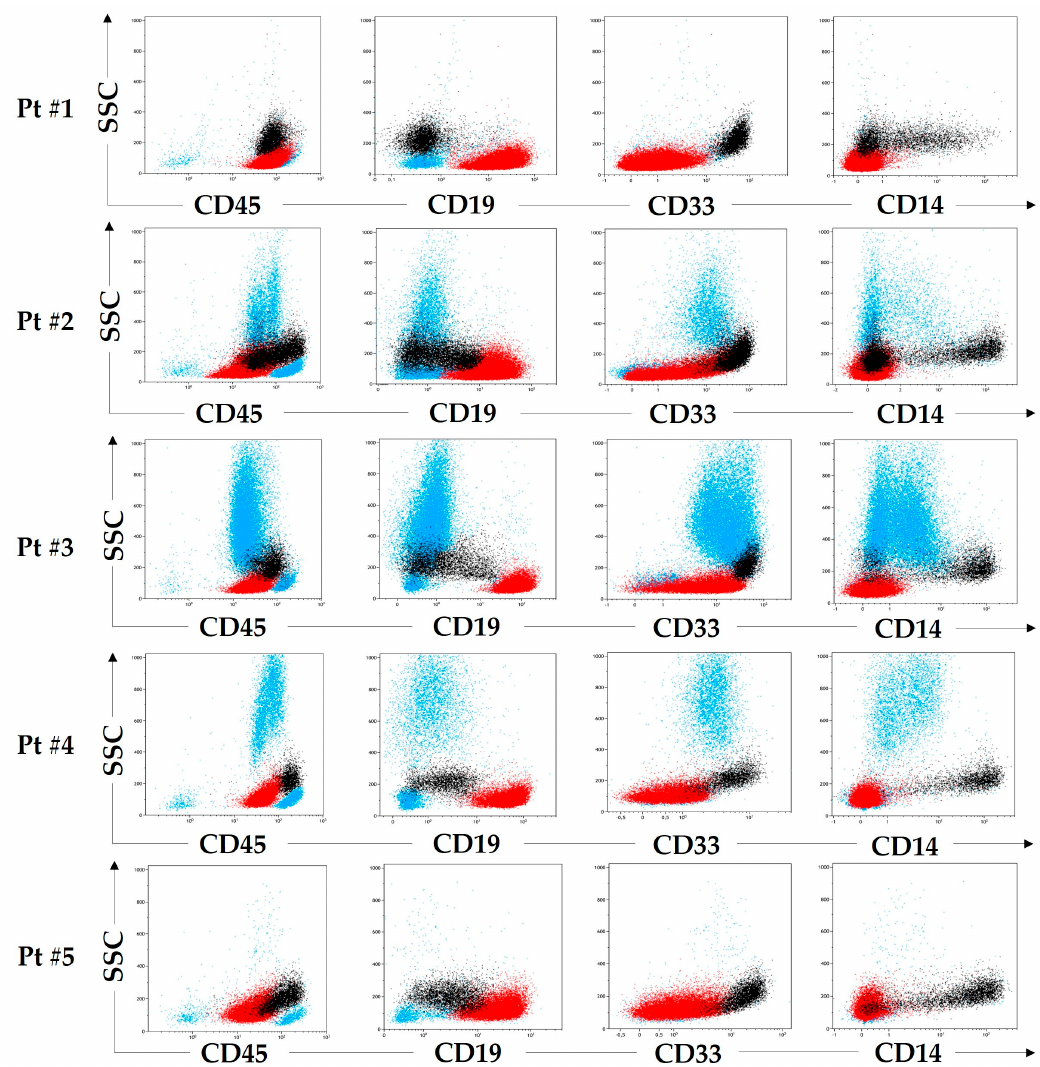
Figure 1. Review of key immunophenotypic features of leukemic B-lymphoblasts (red) and ques- tionable monocyte-like cells (black) in five diagnostic samples. Other nucleated cells are shown in blue.